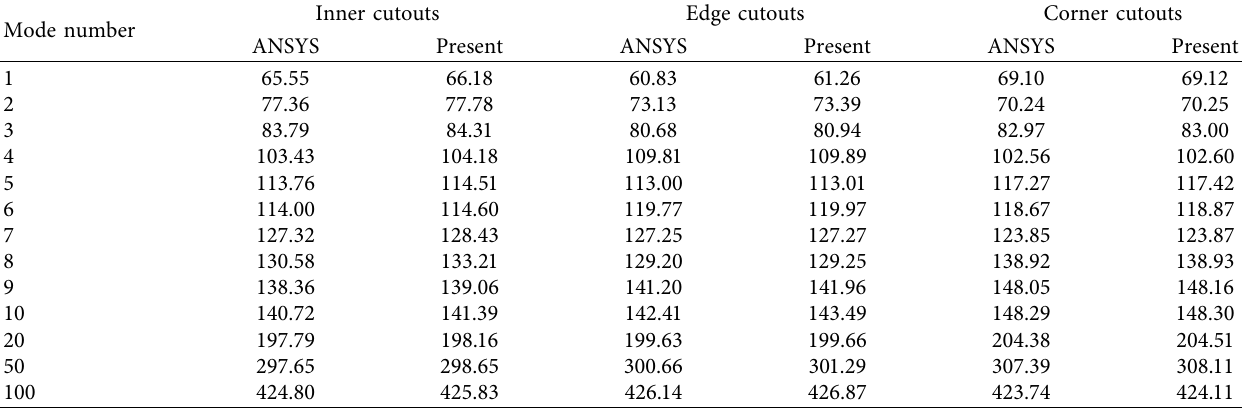
Table 4: The natural frequencies of the rectangular plates for different cutout